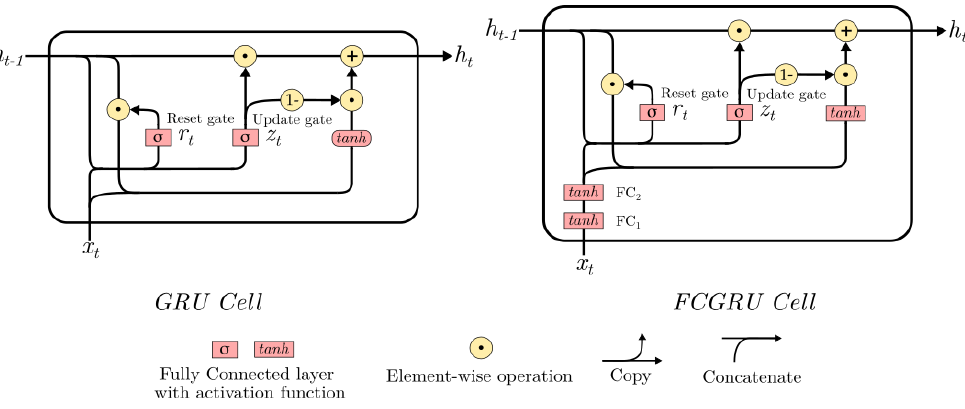
Figure 2. Visual representation of the GRU and FCGRU cells